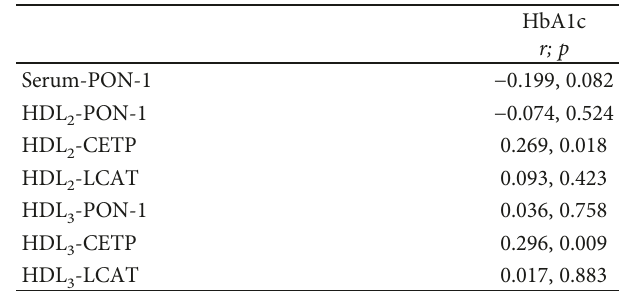
Table 5: Correlations between HbA1c- and HDL-associated proteins and enzymes ( n = 84